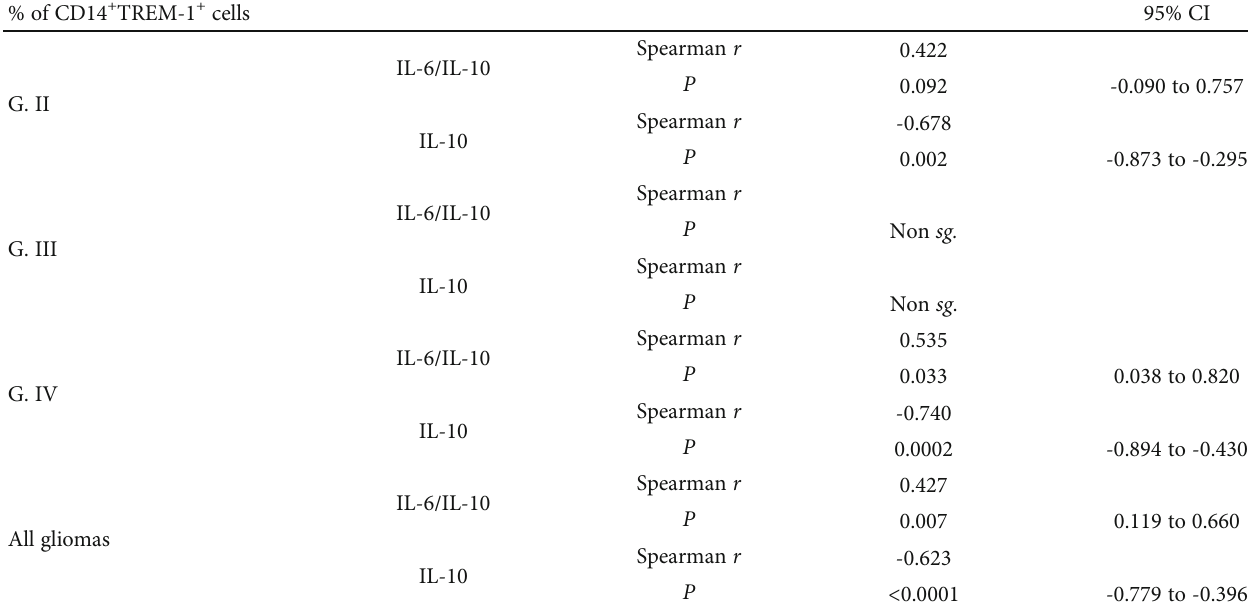
Table 4: Correlations of the percentage of CD14 + TREM-1 + blood cells with IL-6/IL-10 ratio and plasma level of IL-10. % of CD14 + TREM-1 + cells